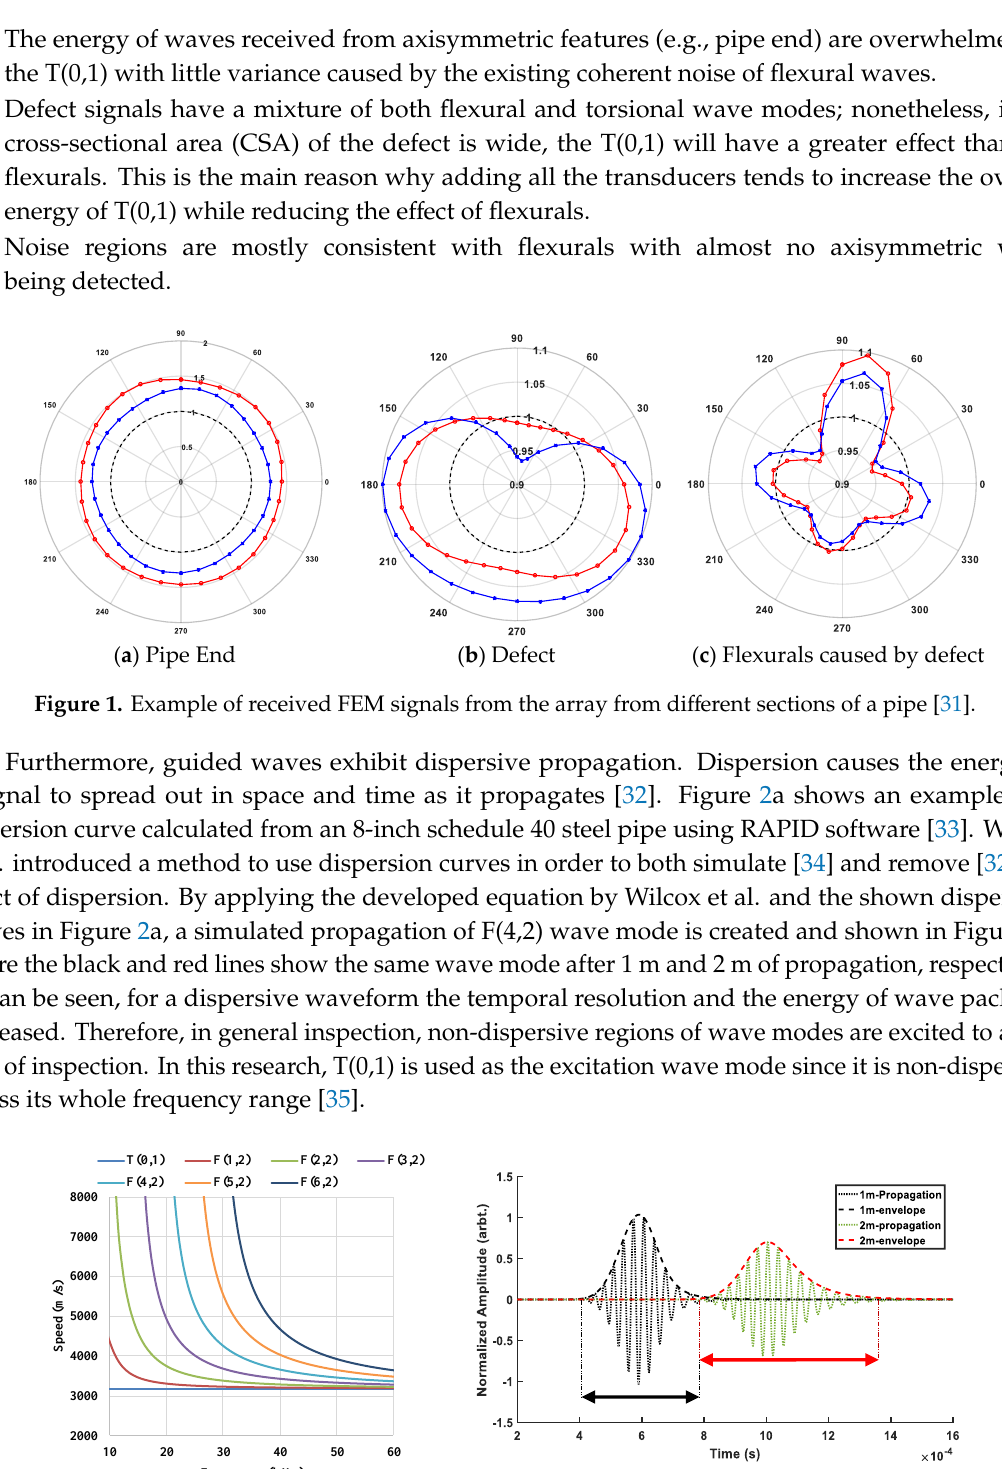
Figure 2. ( a ) Example dispersion curve of T(0,1) wave mode in an 8-inch schedule 40 steel pipe. ( b ) The effect of dispersion on a simulated flexural wave, two propagation distances [31].